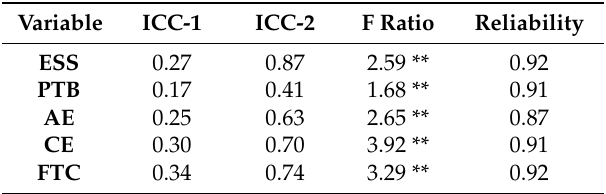
Table 1. Intraclass Correlation Coefficients for Observed Variables and Scale